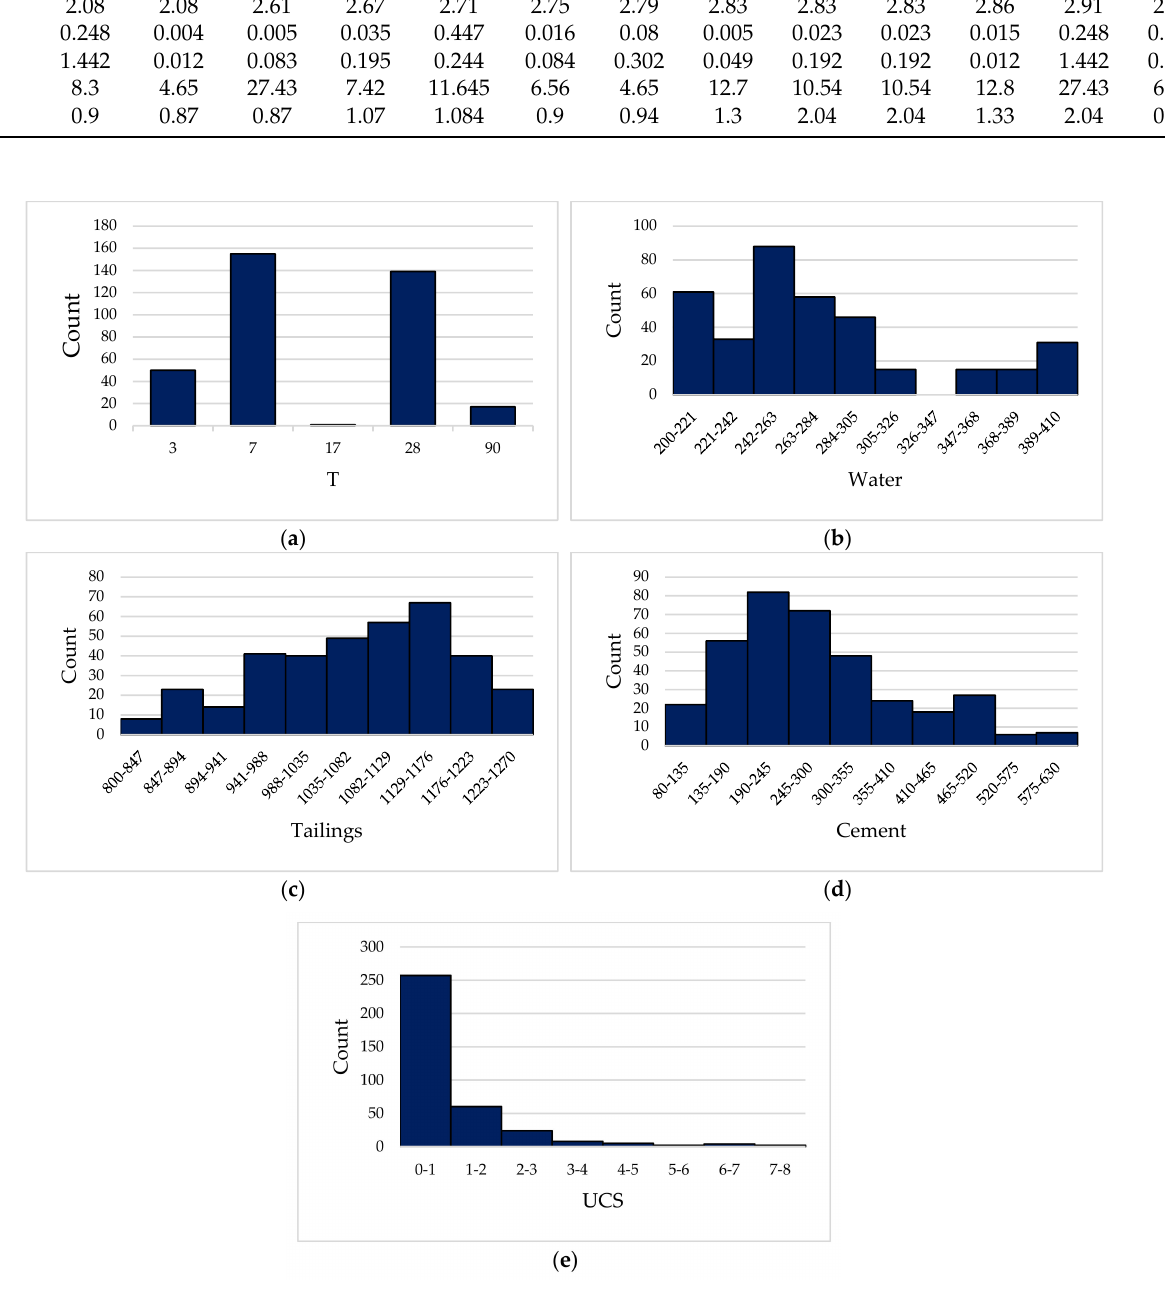
Table 1. Physical characteristics of tailings.